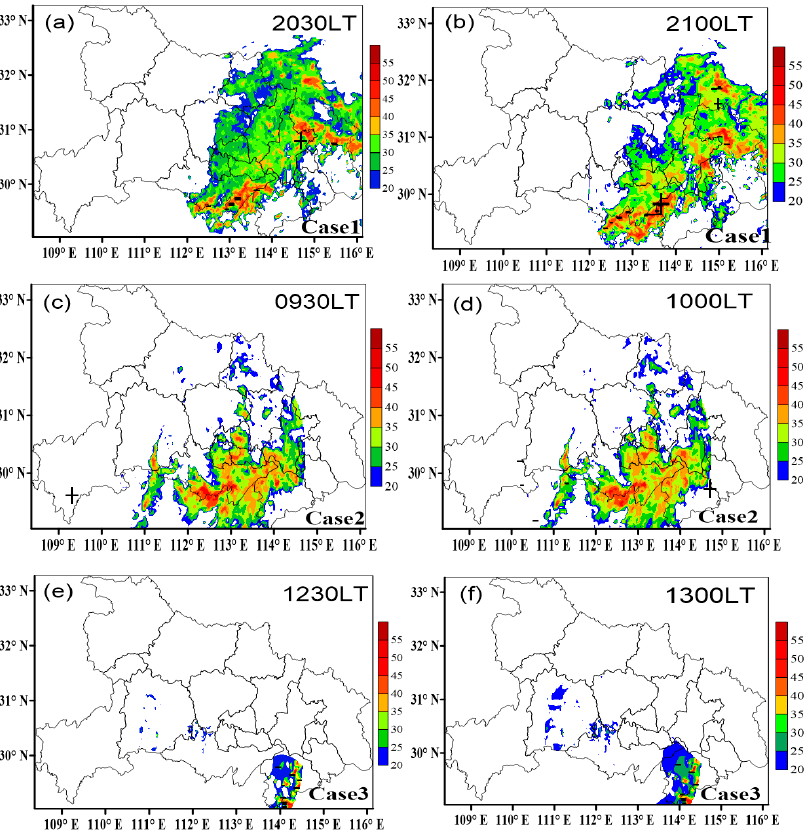
Figure 3. Cloud-to-ground (CG) lightning distribution superposed on the plan position indicator (PPI) of radar reflectivity at an elevation angle of 0.5 ◦ before the precipitation peak in Case 1 ( a , b ), Case 2 ( c , d ), and Case 3 ( e , f ). The symbols “ + ” and “ − “ represent positive and negative CG lightning within 6 min of the radar scan time, respectively.